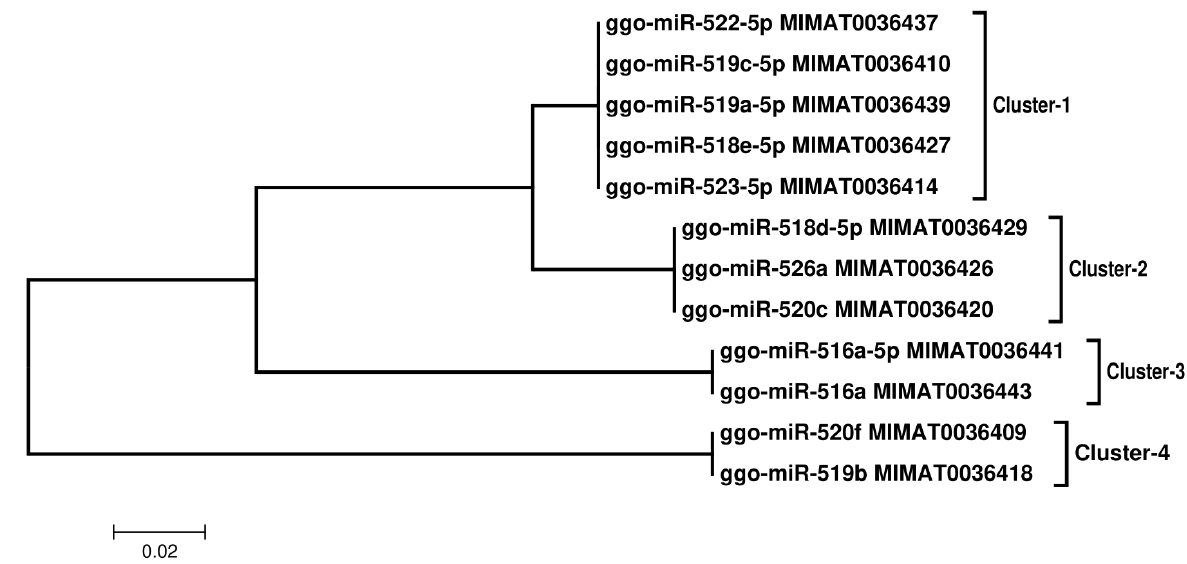
Figure 2. Represents evolutionary relationships of taxa for Gorilla gorilla . The optimal tree with the sum of branch length = 0.40606061 is shown. The analysis involved 12 nucleotide sequences.